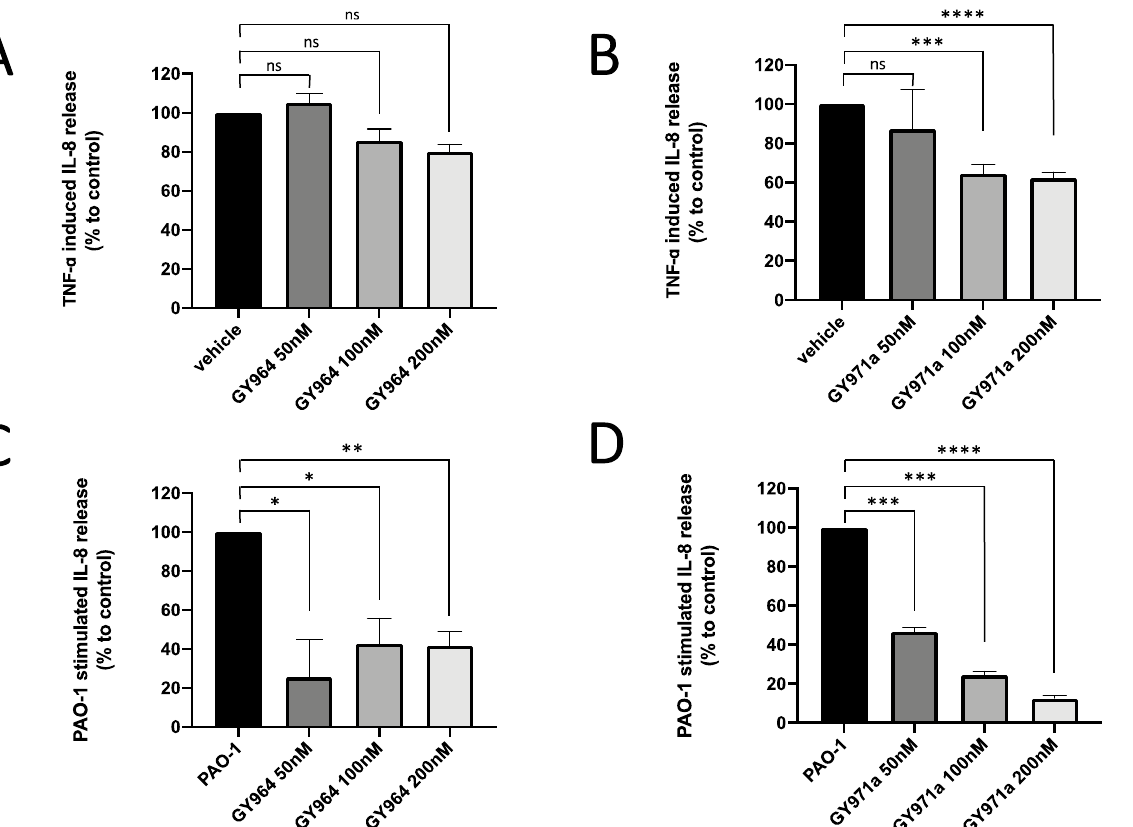
Figure 6. IL-8 release (% to control) in IB3-1 cells treated with different concentrations of GY964 (4-PhDMA) ( A , C ) and GY971a (pANDMA) ( B , D ) with respect to TNF-α-stimulated ( A , B ) or PAO1-infected ( C , D ) IB3-1 cells. Statistics were performed by ANOVA, using Graph Pad Prism 9.0, where statistical significance at the levels of p < 0.05 (*) p < 0.01 (**), p < 0.005 (***), p < 0.0001 (****) is reported, together with non-significance (ns).